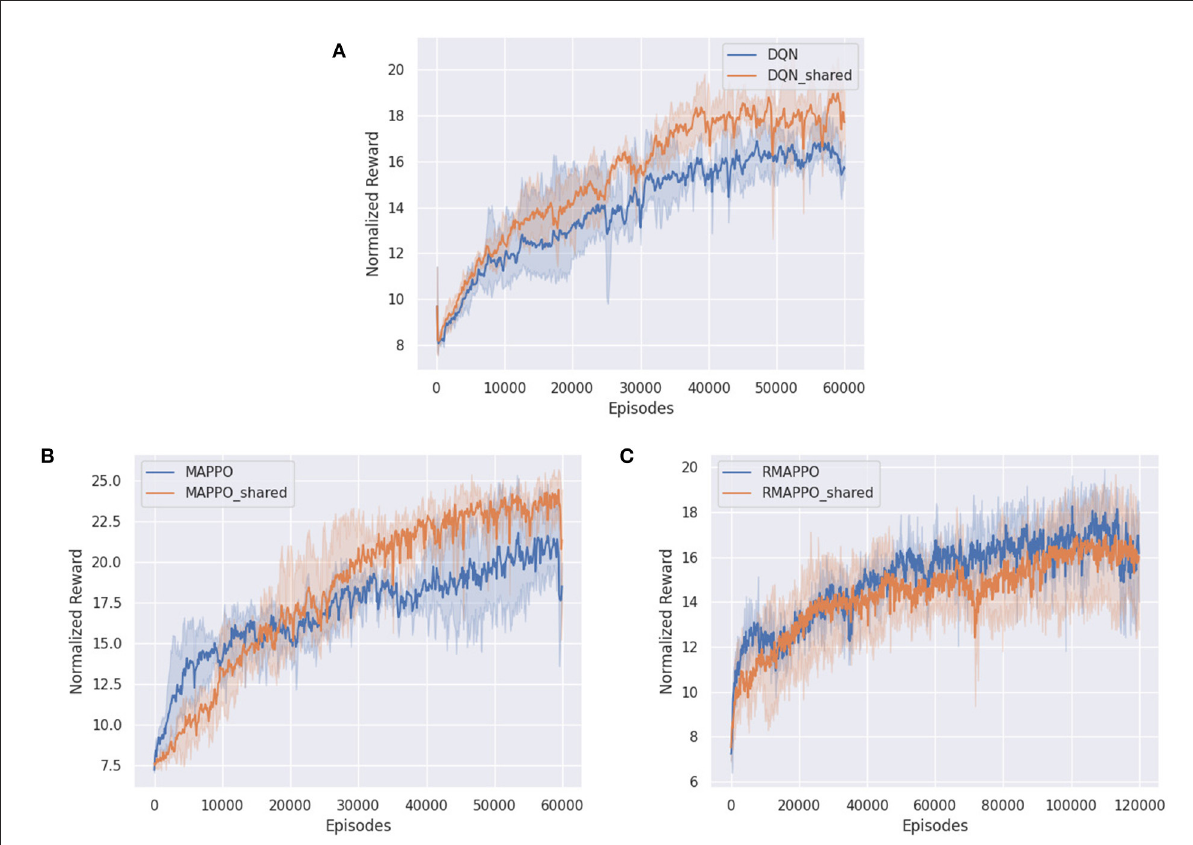
FIGURE2 Training curves of various algorithms in Space Invaders, comparing when individual rewards are given (blue) to when team rewards are given (orange). (A) Shows training curve of DQN, (B) shows training curve of MAPPO, (C) shows training curve of RMAPPO.